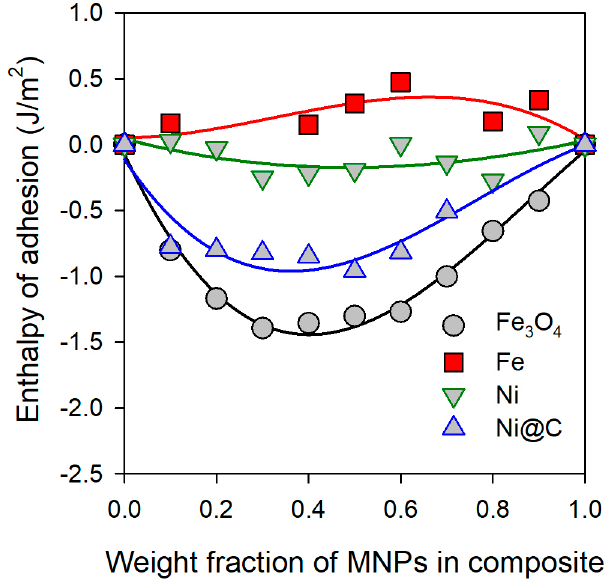
Figure 8. Concentration dependences of the enthalpy of adhesion of Na-alginate polymer to the surface of MNPs. Temperature 25 °C. Lines are drawn for the eye-guide only.